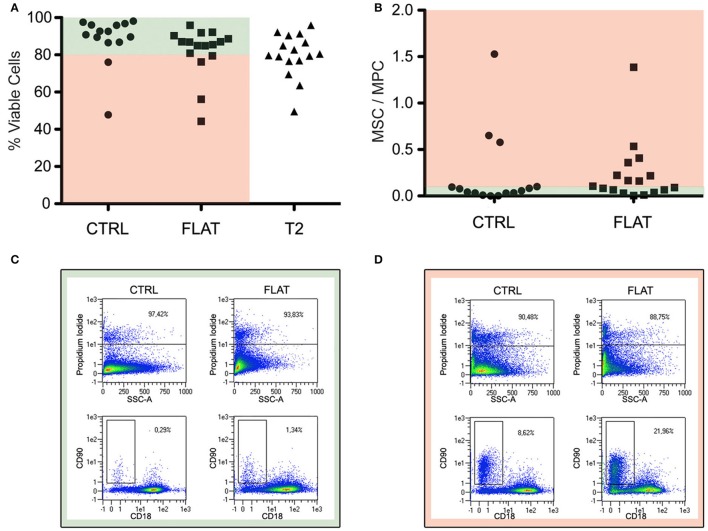
Evaluation of cell viability and spontaneous differentiation. (A) Percentage of viable cells (PI-negative) for the different substrates. (B) Spontaneous differentiation, evaluated by ratio between MSC and MPC percentages, in control sub-cultures and “FLAT” conditions. Red and green areas indicate data from experiments that were considered valid (i.e., viability >80% and MSC/MPC <0.10 on controls). (C) Dot plots of representative sample included in the study. (D) Dot plots of representative samples excluded from the study for its consistent spontaneous differentiation in non-nanostrucutred controls.